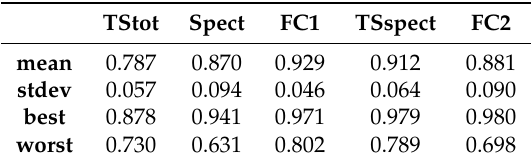
Table A3. Accuracy for wideband excitation (150kHz to 20kHz); grouped by shapes. Compare also Figure 8a.